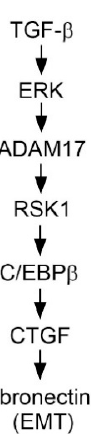
Figure 9. Simplified image displaying the results of TGF- β -induced CTGF expression mediated via the ERK/ADAM17/RSK1/C/EBP β pathway in human lung epithelial cells. TGF- β activated the ERK/ADAM17/RSK1/C/EBP β signaling pathway, which in turn initiates binding of C/EBP β to the CTGF promoter and ultimately induces CTGF expression in human lung epithelial cells. Moreover, ADAM17 and CTGF participated in TGF- β -induced FN expression.